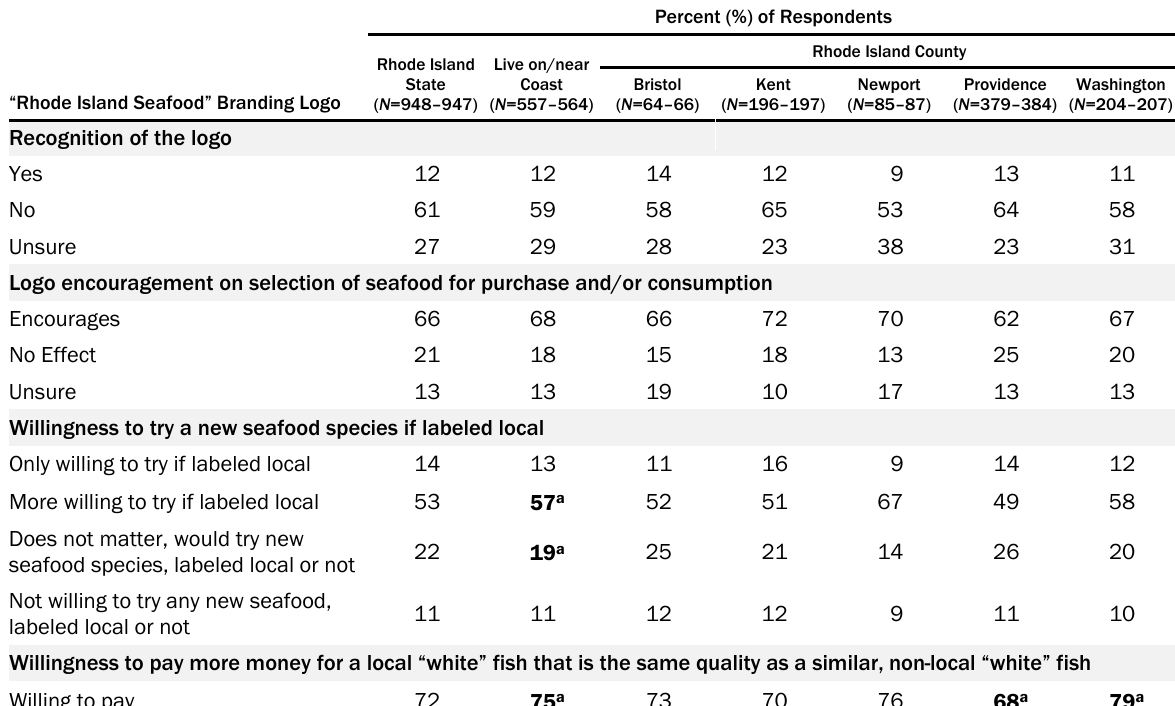
Table 9. “Rhode Island Seafood” Branding Logo: Consumer Recognition of the Logo and its Influence on their Seafood Consumption and Purchasing Choices Percent (%) of Respondents